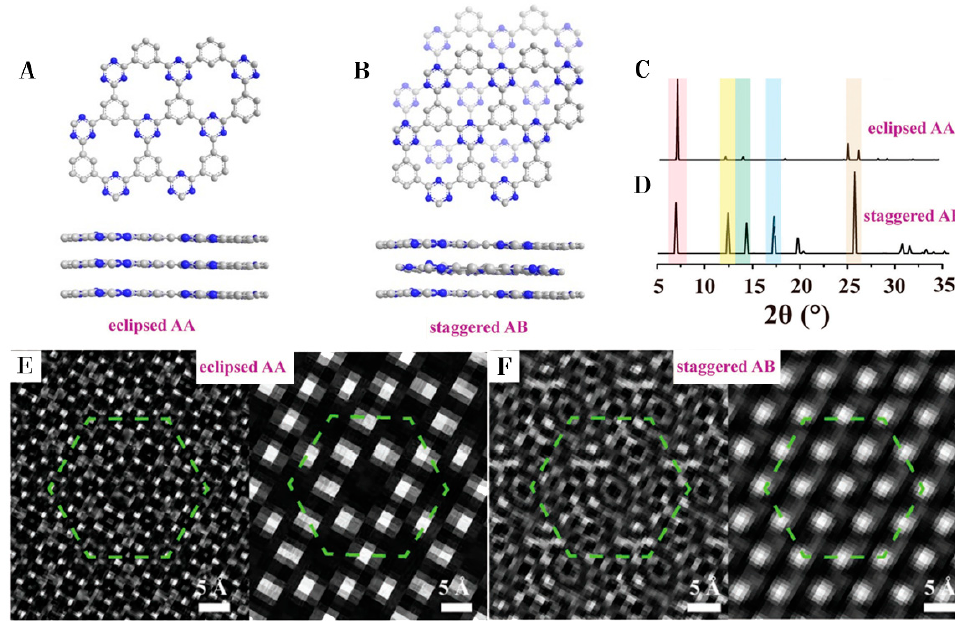
Figure 4. Two possible stacking arrangements with their ( A , B ) estimated structure, ( C , D ) calculated XRD, and ( E , F ) simulated HRTEM [31]. Note: ( A , C , E ) eclipsed AA stacking; ( B , D , F ) staggered AB stacking.